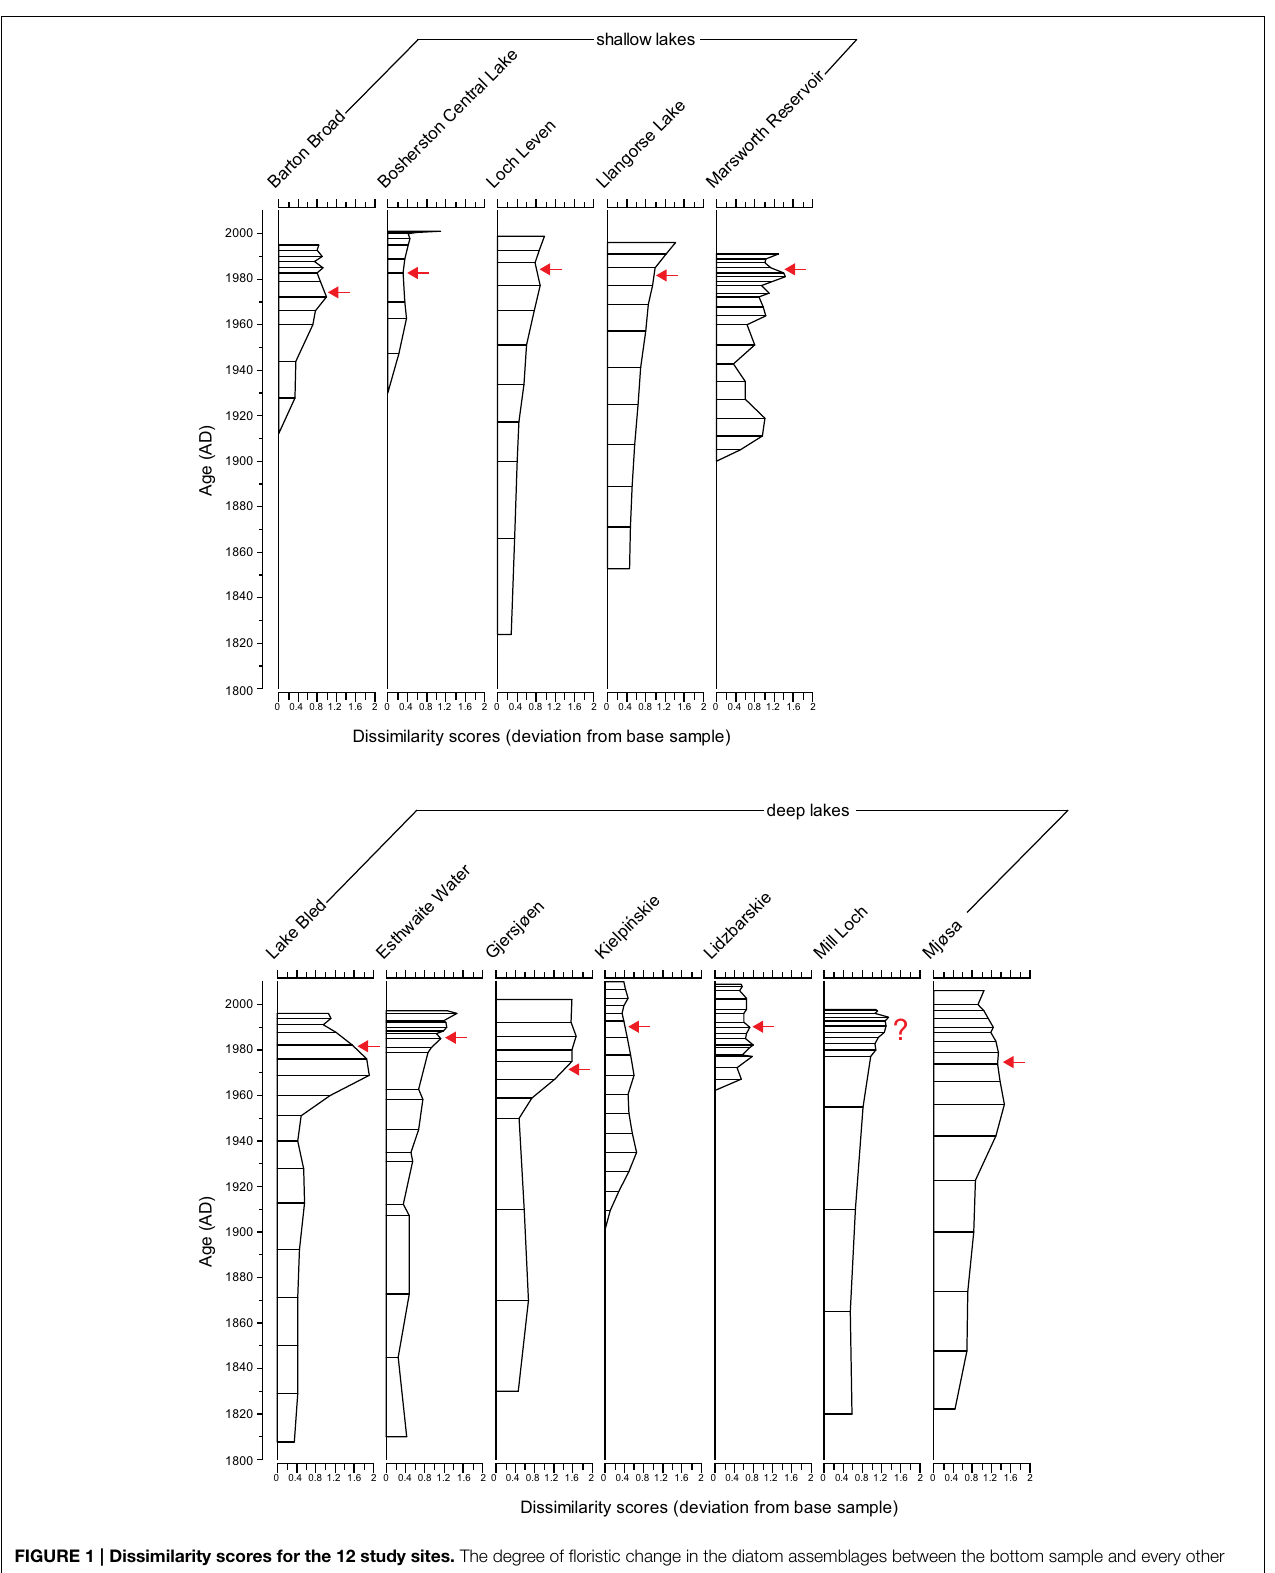
Frontiers in Ecology and Evolution |